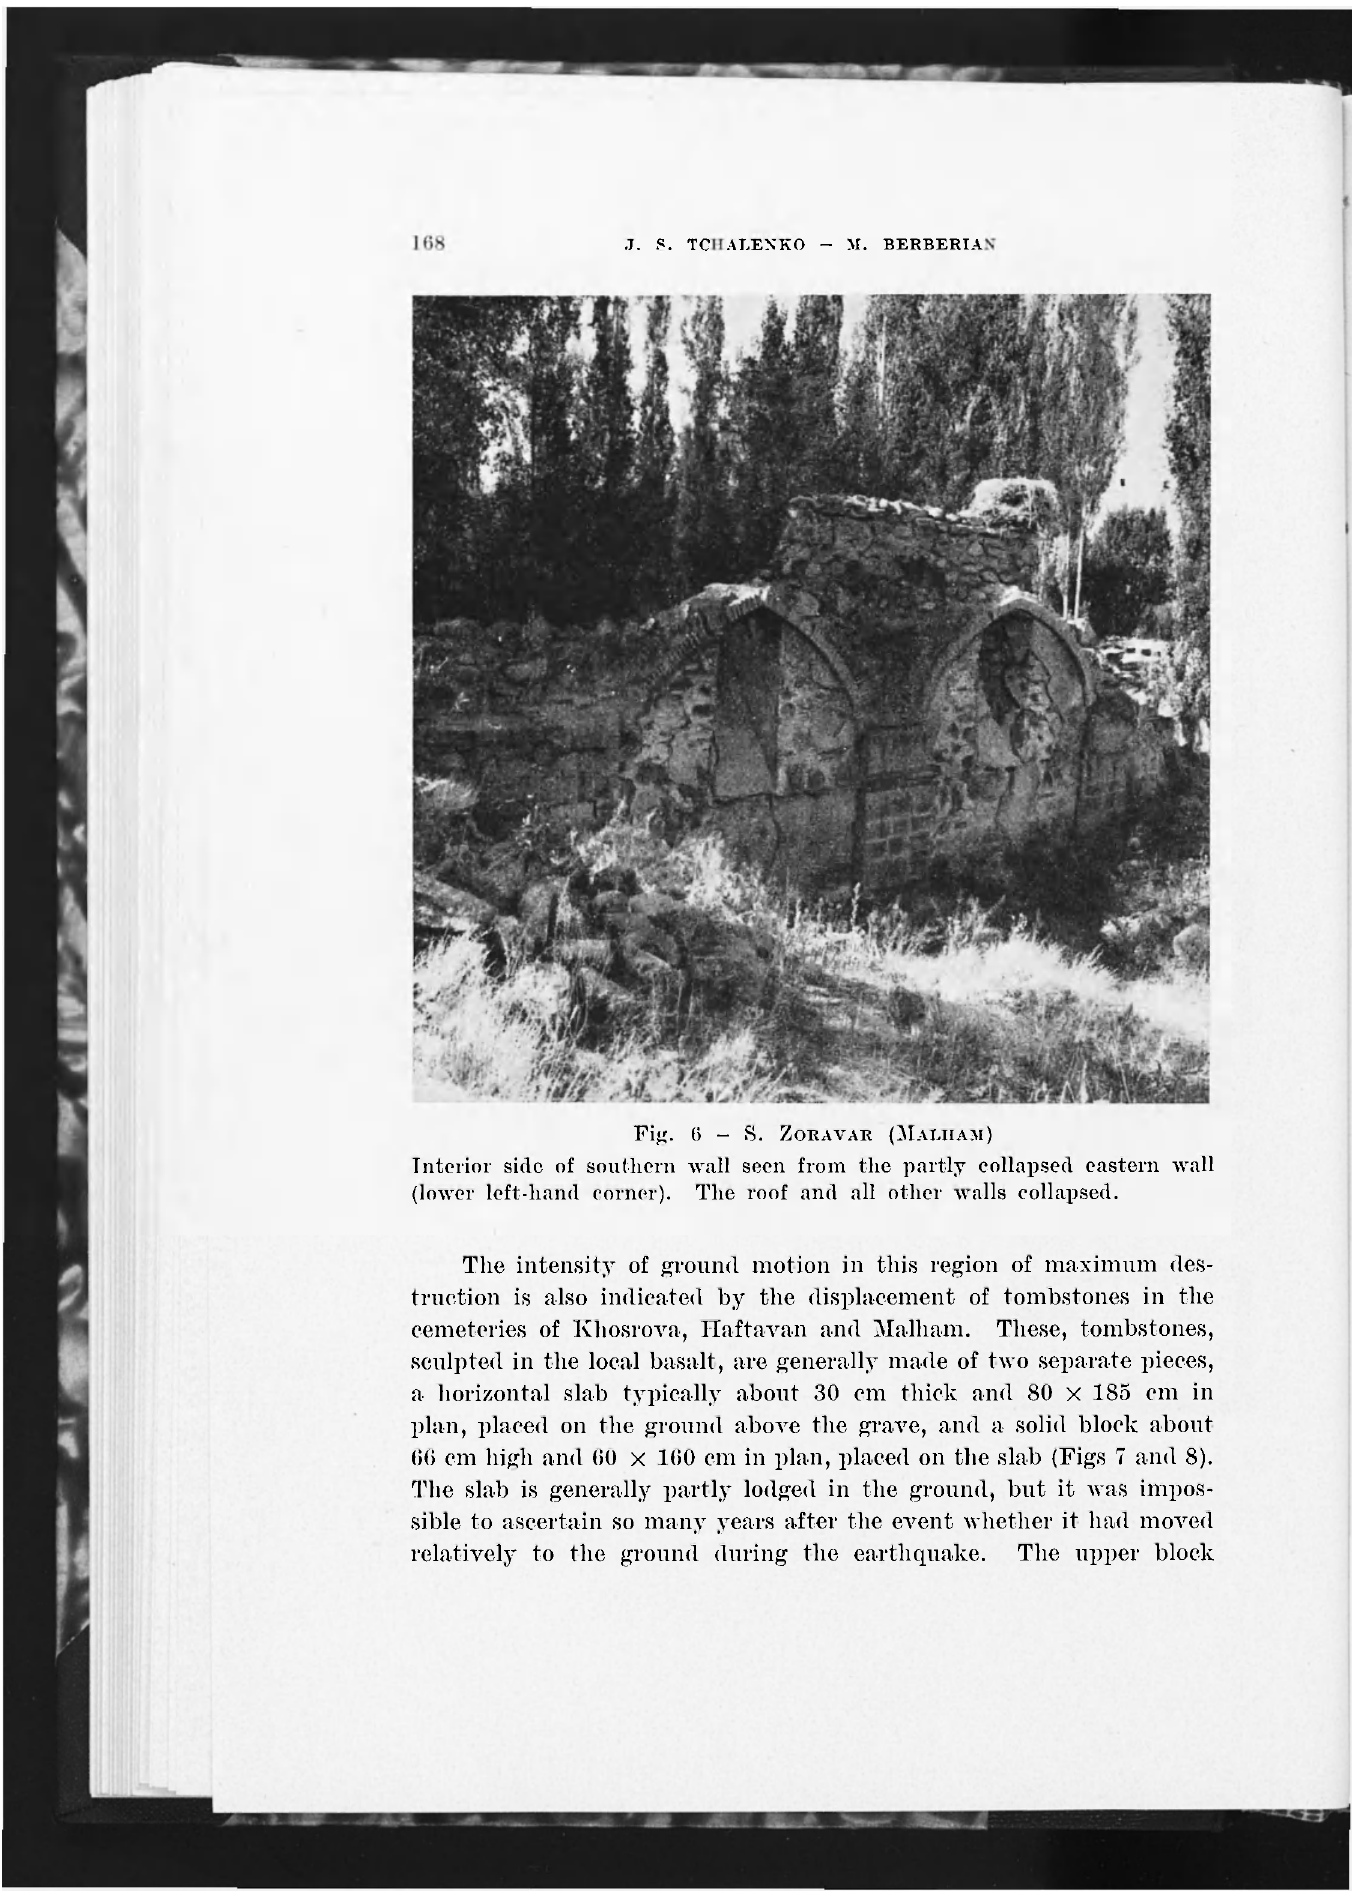
Fig. 6 - S. ZORAVAR (MALHAM) Interior side of southern wall seen from the partly collapsed eastern wall (lower left-hand